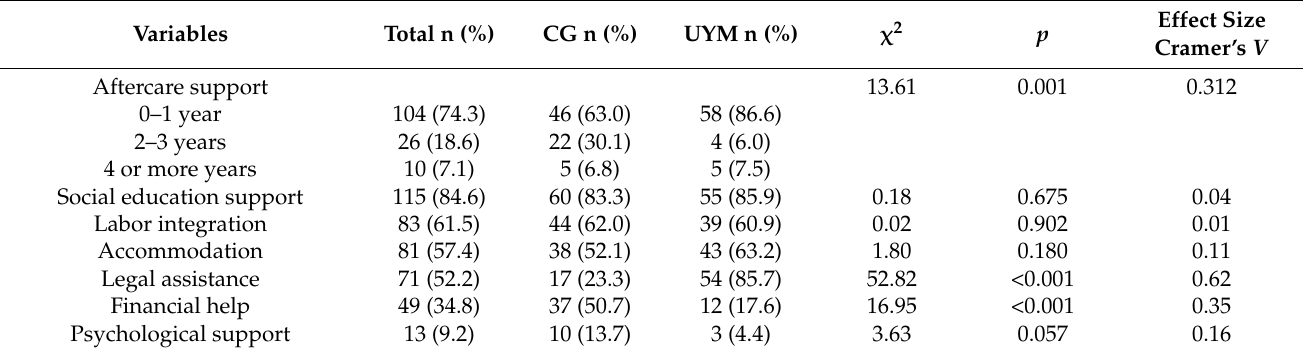
Table 5. Aftercare Support. Differences between